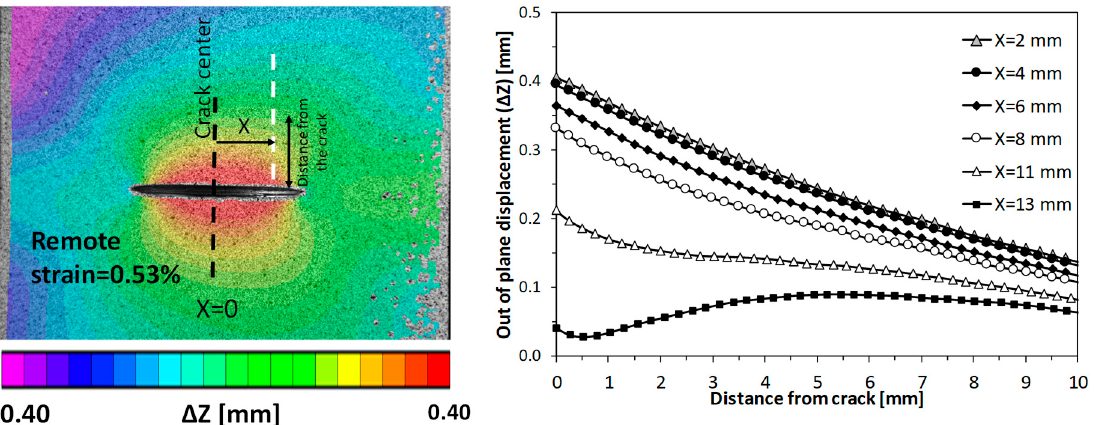
Figure 4. Out-of-plane measurement along the crack